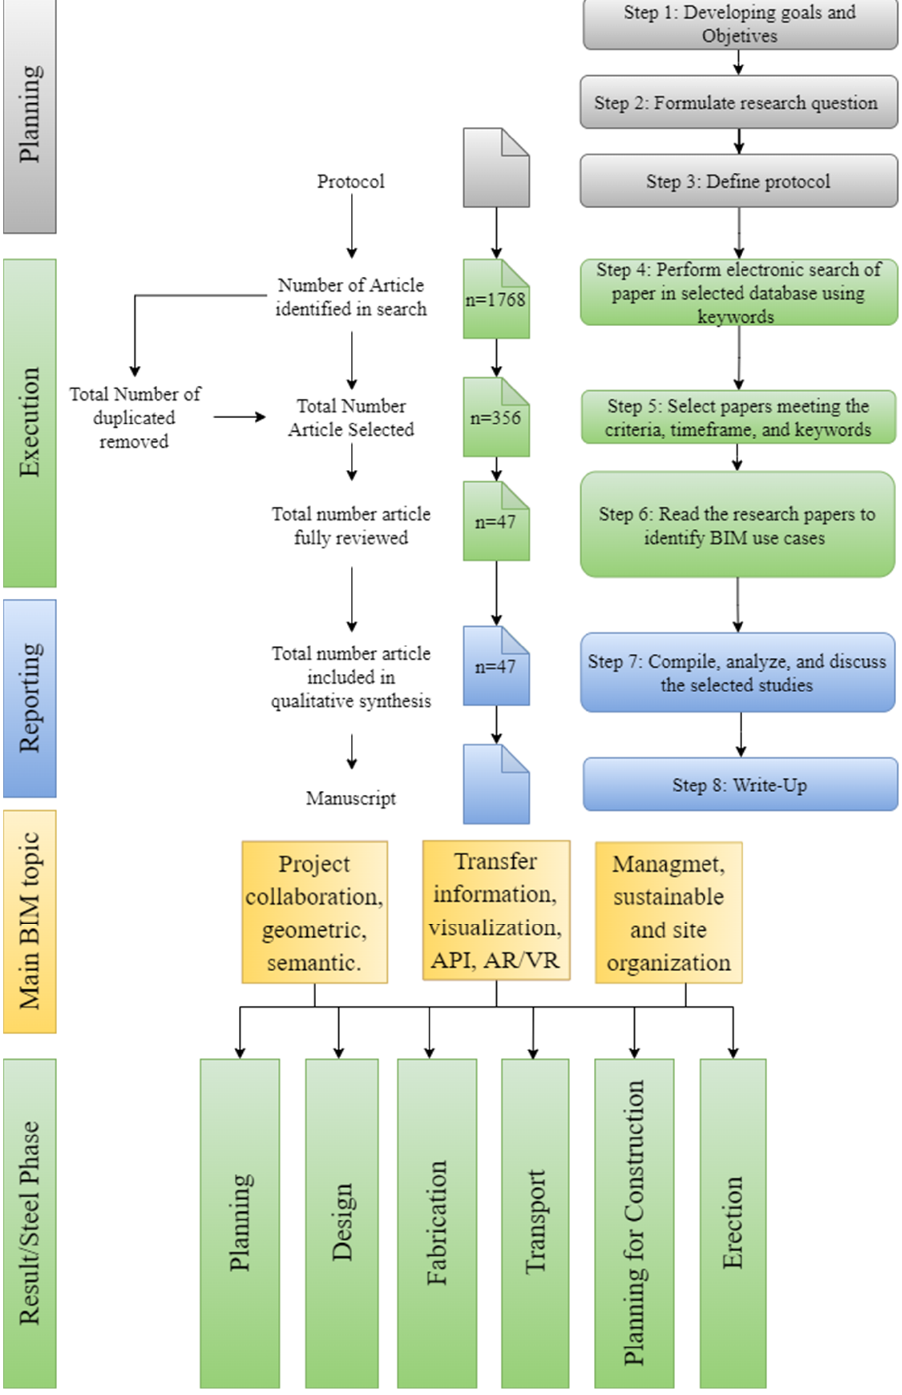
Figure 1. SLR process for this article. (Modified from Kim and Brown) [41].